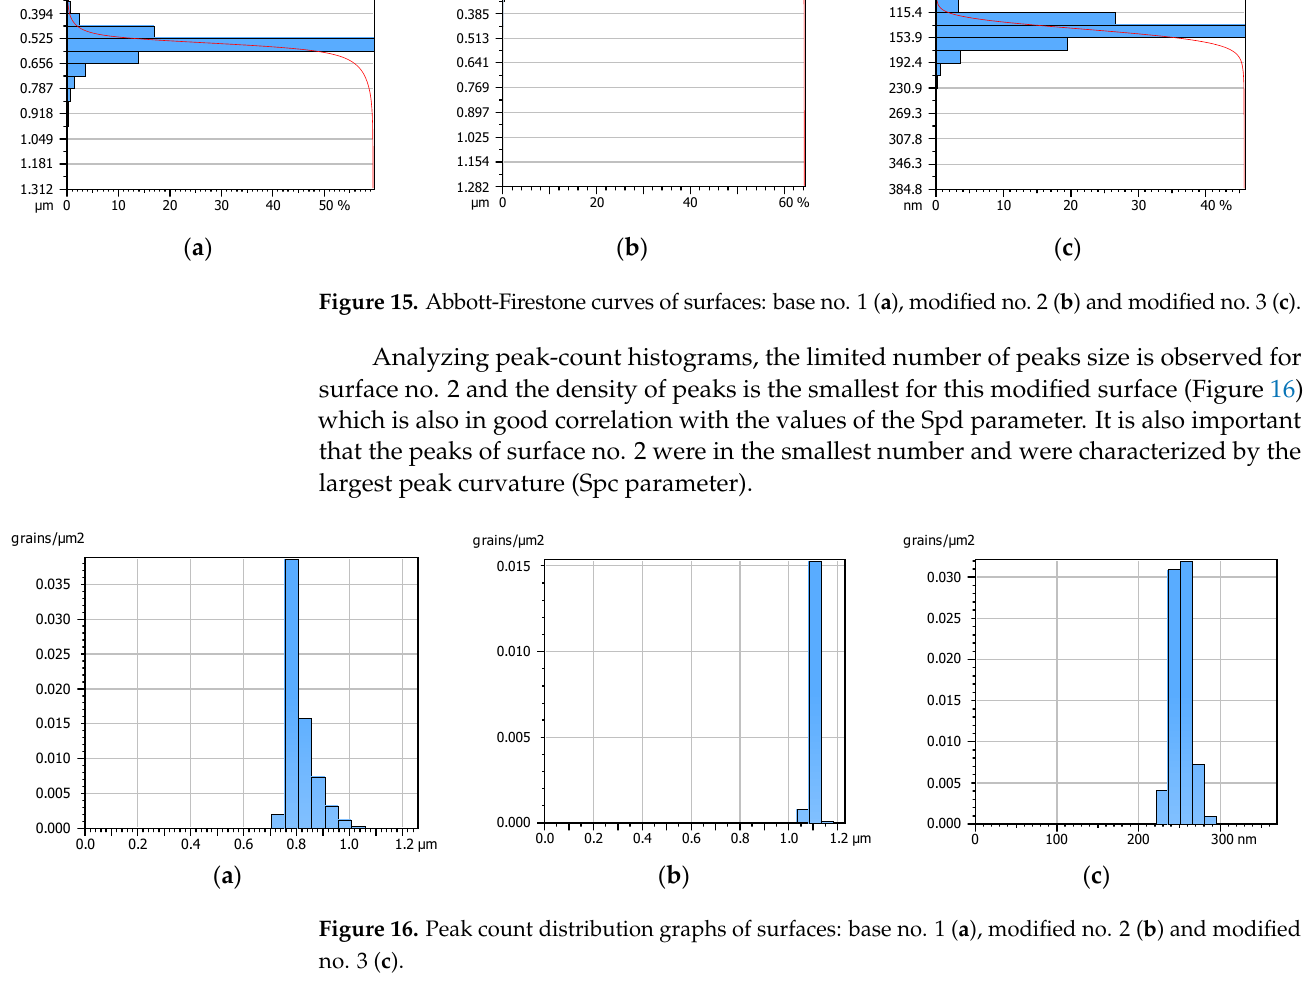
Taking into account the size and frequency of the peaks and valleys of the analyzed surfaces, the volume parameters should differ substantially, as is confirmed by graphic representation in Figure 17.